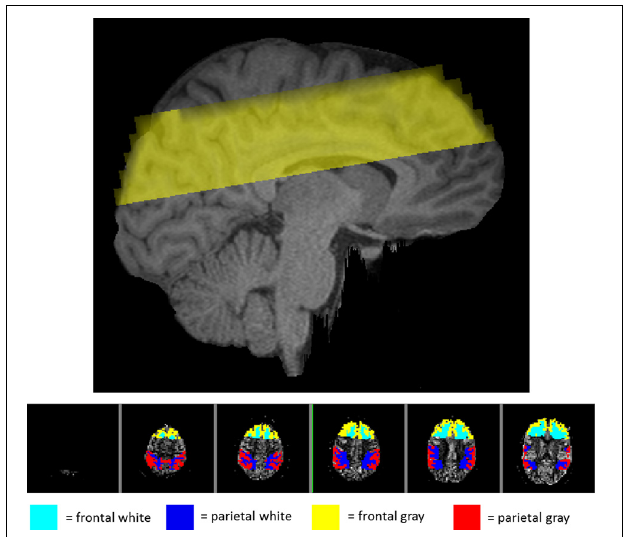
FIGURE 1 | View of the regions imaged in one representative subject. Top panel: sagittal view of the location of the imaging volume taken in the study for one representative subject. Bottom panel : axial view of the imaging slices shown from superior (left) to inferior (right) with the frontal and parietal regions highlighted. The teal and blue areas represent the white matter in the frontal and parietal regions, respectively. The yellow and red represent gray matter in the frontal and parietal